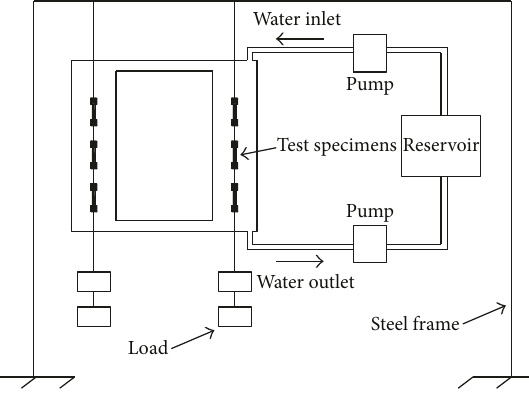
Figure 1: Schematic of the wet-dry exposure set-up.